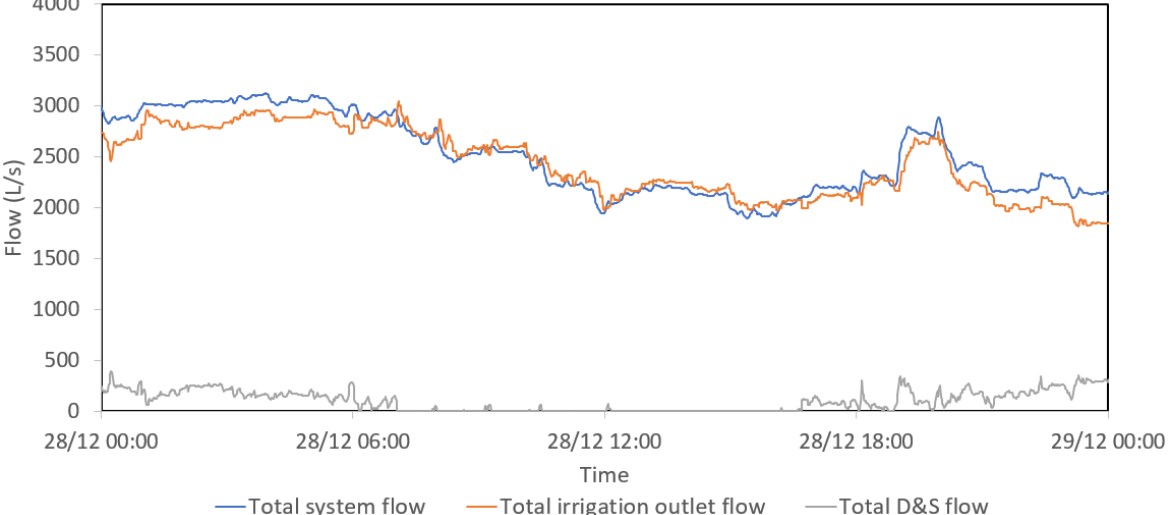
Figure 3. Total flow of each demand category during the calibration period.